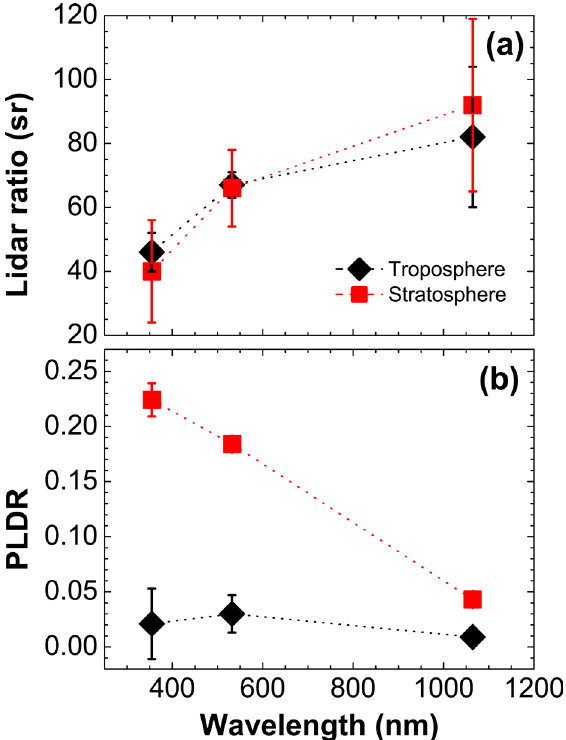
Figure 2 Spectral behavior of the lidar ratio (a) and particle linear depolarization ratio (b) of smoke in the troposphere (black diamonds, 5 – 6.5 km height) and stratosphere (red squares, 15 – 16 km) over Leipzig on 22 August 2017.